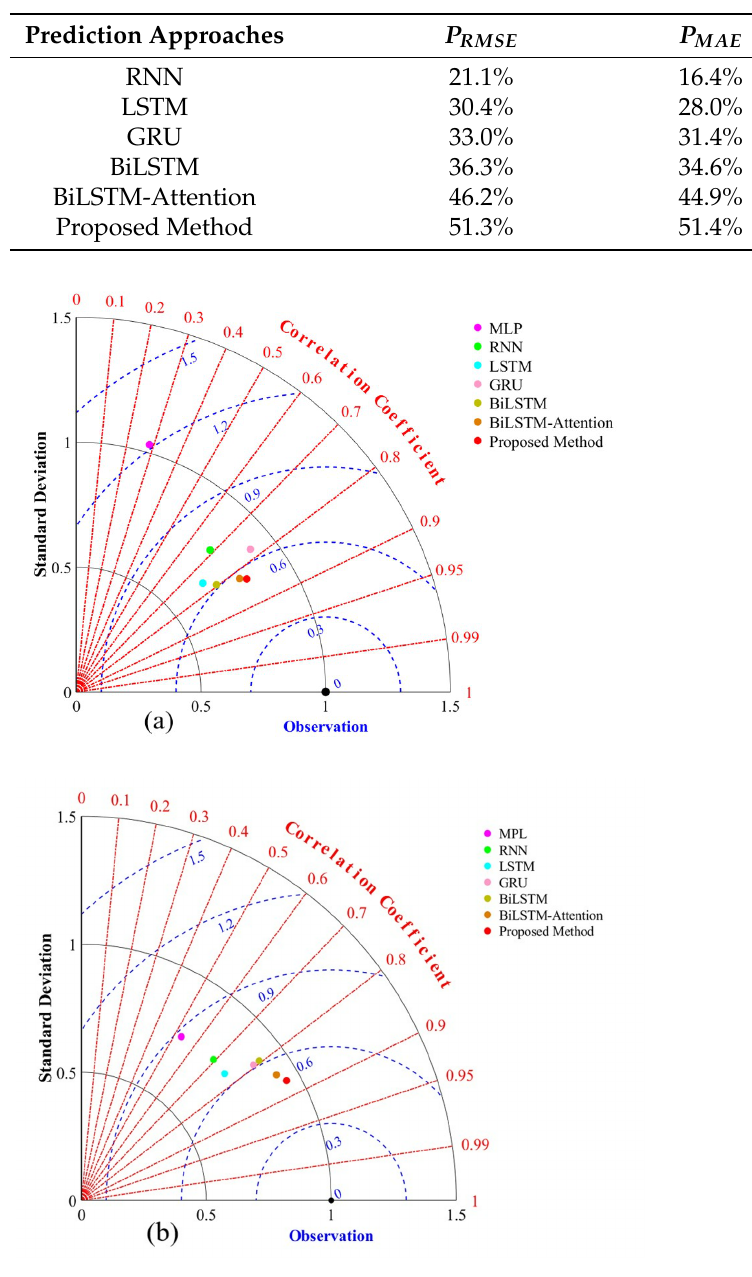
Table 3. Percentage Improvement of Methods in Comparisons with MLP (dataset B).